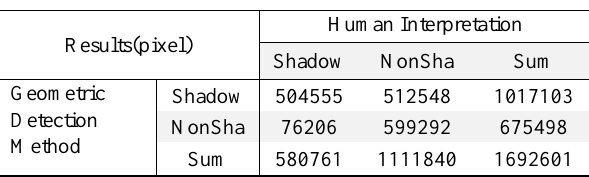
Table 1. Comparison of human interpretation and geometric